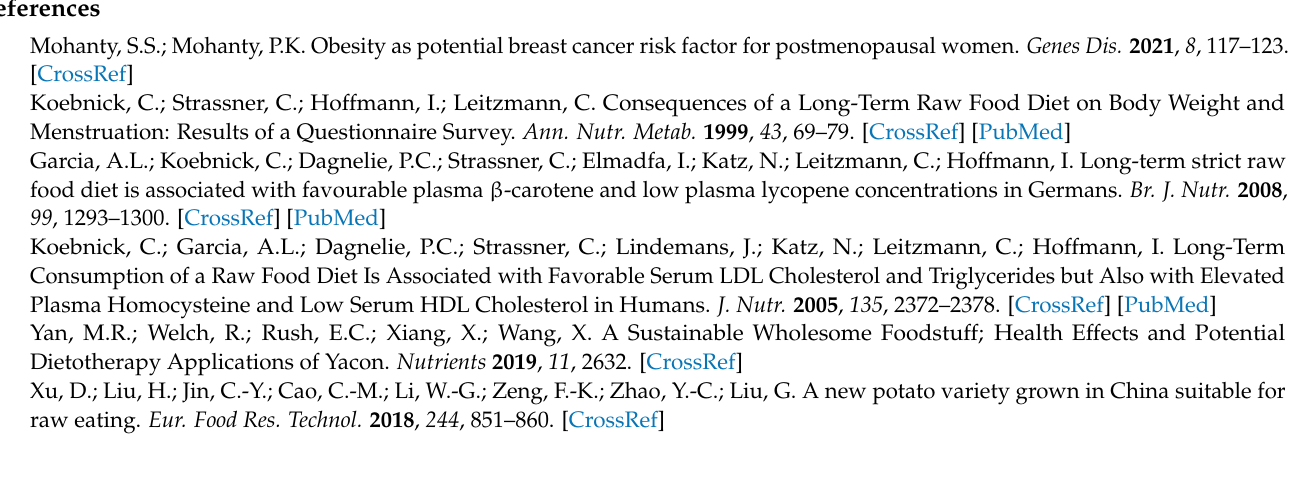
potato varieties; Table S2: The quality indicators of the tuberous root of 81 varieties; Table S3: KMO and Bartlett’s Tests of principal component analysis; Figure S1: Biplot graph of principal component